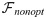
Context-enhanced odor processing in cluttered environments: Distracting stimulus.(A,D) Training stimuli 1,2 and 3,4 were associated with contexts 1 and 2, respectively. (B,C) learned disynaptic inhibitory connections among MCs (W(MM)) and from CCs to MCs (W(MC)). Colors indicate the number of GCs mediating that inhibition. (E) The probe stimuli (right panel) consisted of a pair of similar, weaker target odors (open black and solid red symbols, left panel) on top of training stimulus 3 (black solid line without symbols, middle panel) as a strong distractor. Sketch of connections indicate an optimal read-out that focuses on the target odors and a non-optimal, random read-out. (F,G) MC activities in response to the probe stimuli with and without context. (H) The correct context suppressed the distractor and enhanced the Fisher discriminant Fnonopt of the random read-out. In contrast, the incorrect context reduced Fnonopt. With top-down input blocked (wGC = 0) Fnonopt is slightly reduced compared to the context-less case. The error bars quantify the fluctuations in the network connectivities.